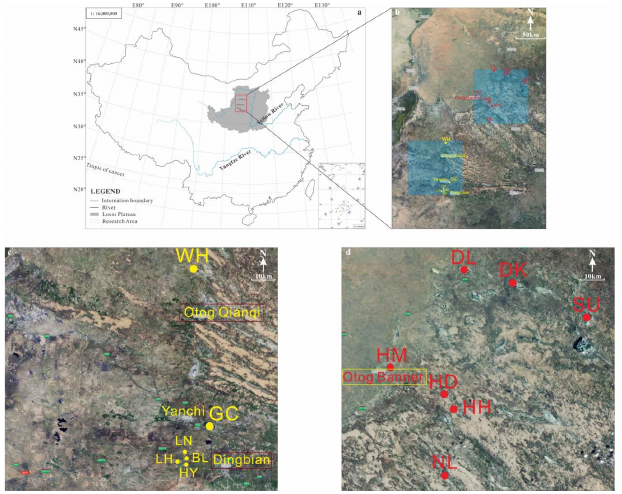
Figure 1. Location of the sampling sites in the Ordos Plateau, China. ( a ) and ( b ): Sketch map of the sampling basin/province. ( c ): Sampling location of sulfate-type saline lakes. ( d ): Sampling location of carbonate-type saline lakes. (Yellow dots, sulfate-type saline lakes; r ed dots, carbonate-type saline lakes).